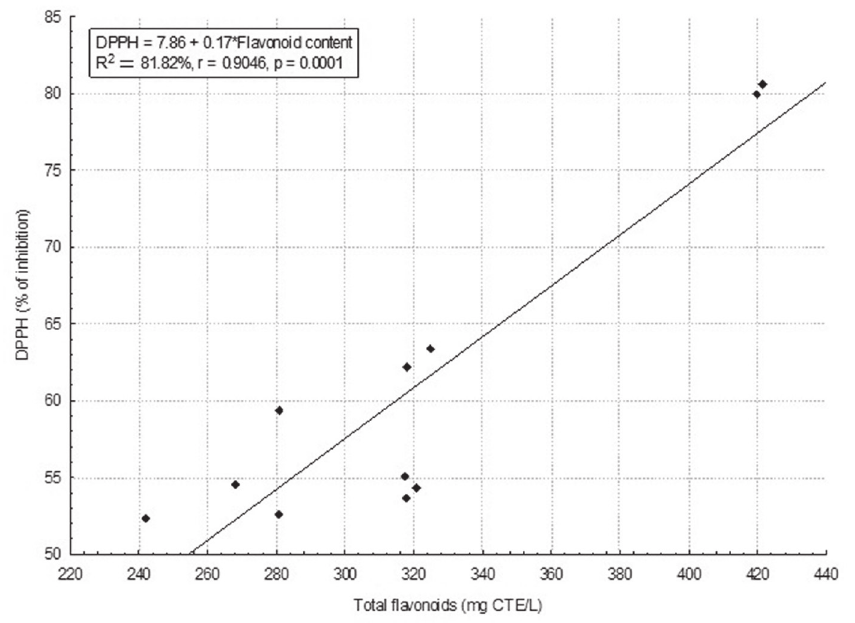
Figure 2 - Linear Regression Analysis between the total flavonoid content and the antioxidant capacity towards the DPPH